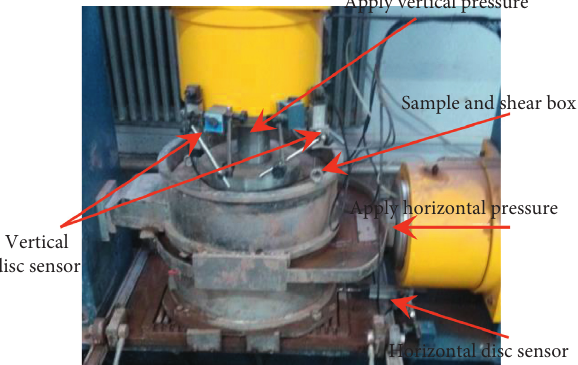
Figure 3: Large strain-controlled direct shear